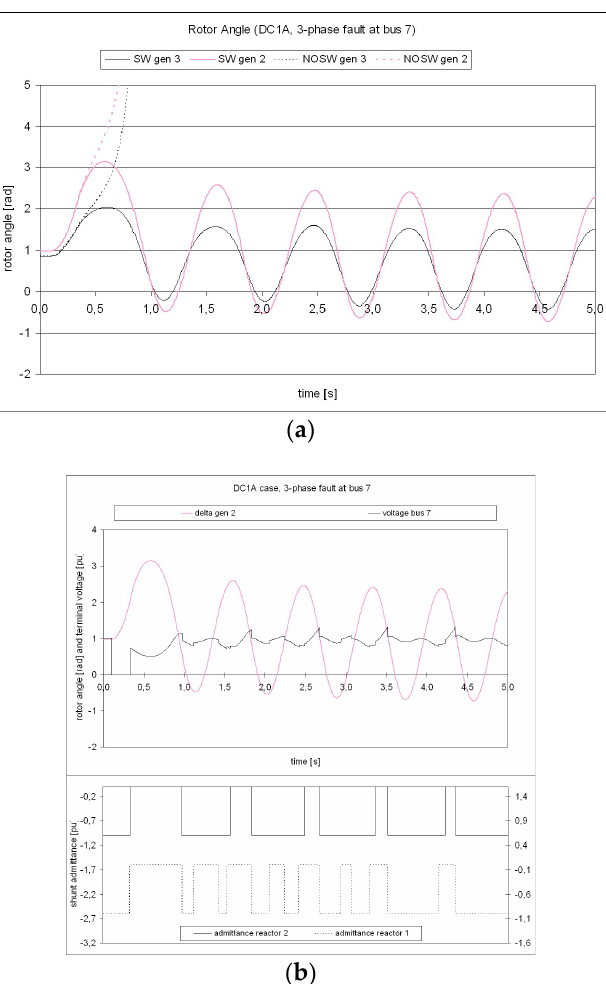
Figure 4. Simulation results of IEEE test system with DC1A exciter: ( a ) Rotor angles of generators G2 and G3 (relatives to generator G1) for a three phase fault on bus 7, with and without shunt reactors switching; ( b ) Rotor angle of generator G2 (relative to generator G1), voltage of bus 7, shunt admittances of two reactors, for a three phase fault on bus 7, with reactors switching.